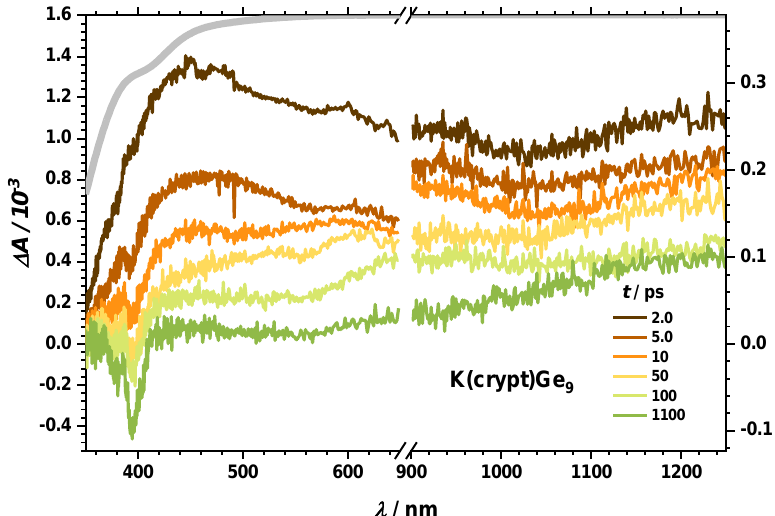
Figure 3. Broad transient absorption spectra for K(crypt)Ge 9 in THF after excitation at 267/258 nm at given delay times. The gray line shows the ground state absorption spectrum with inverted OD axis. The lowered absolute transient response indicates absorption of the white-light probe beam by the sample between 350 and 390 nm.